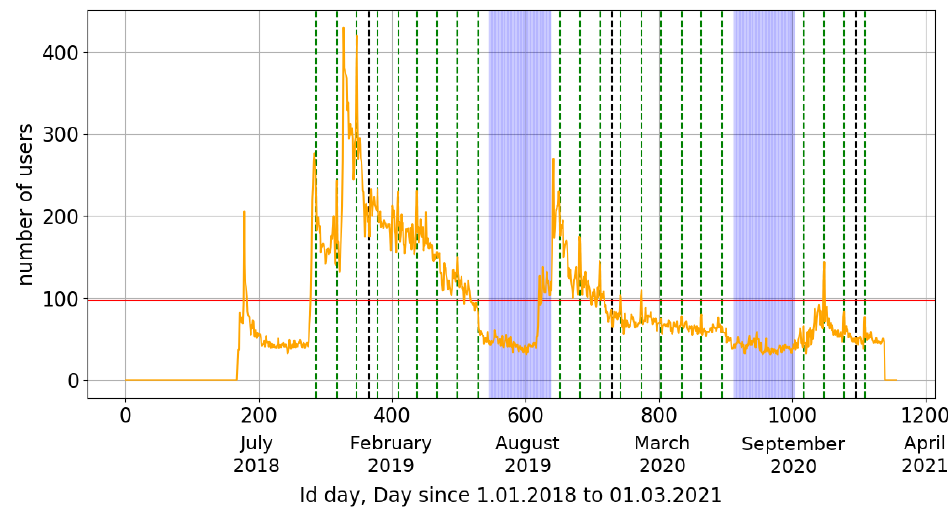
Figure 1. Daily activity of the CREDO Detector application users from the premiere of the application (June 2018) to 1 March 2021. Green lines show the days of the event in the competition for schools. Dashed black lines indicate the beginning and end of a given year. Horizontal red line reflects the average daily number of active users (97). Blue areas indicate areas between two editions of the competition (early July to early